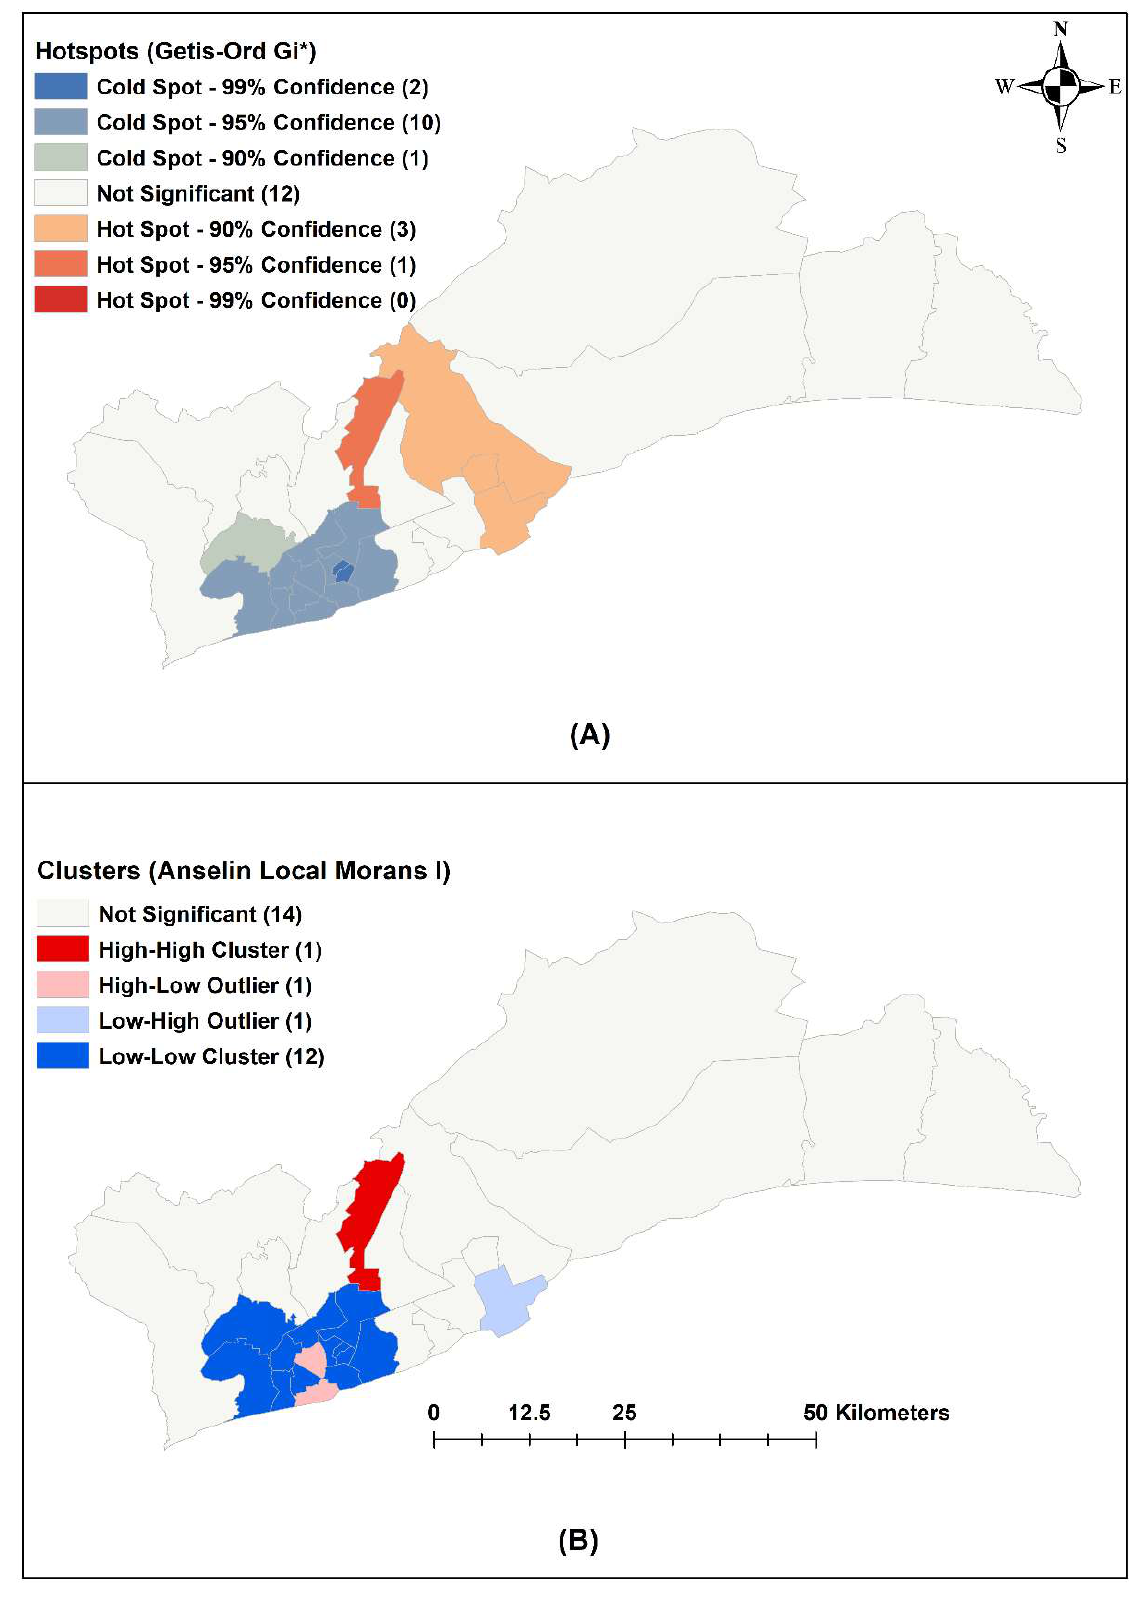
Figure 4. Hotspot analysis of reported malaria cases in the Greater Accra Region, 2015-2019: ( A ) Getis-Ord Gi* statistic; ( B ) LISA—HH is high risk surrounded by high risk, LH is low risk surrounded by high risk.